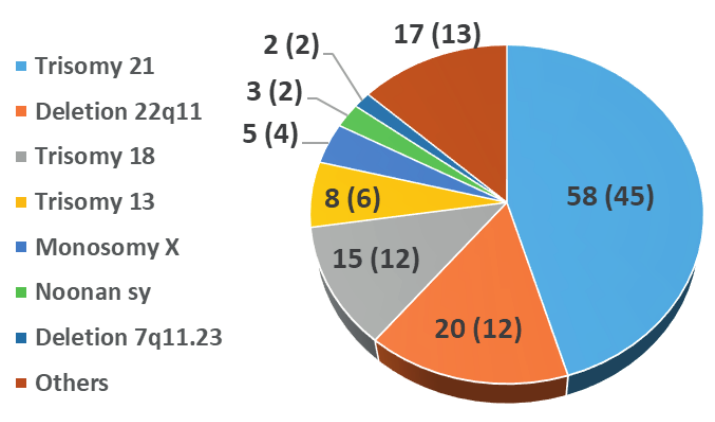
Fig. 3. Representation of genetic syndromes with relation to CHDs, n (%),